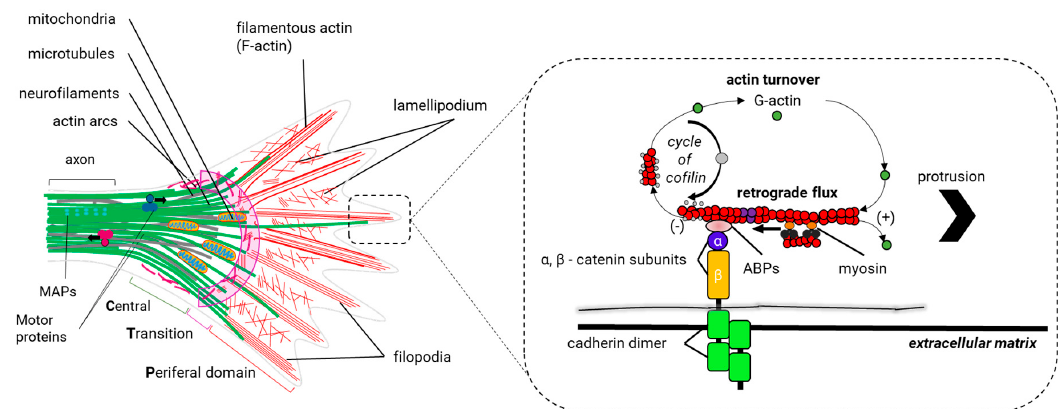
Figure 10. Molecular structure of the cytoskeleton in the growth cone. The growth cone can vary its shape and size very fast, but usually, three domains are distinguished: the central (C) and peripheral (P) domains, and an intermediate zone called the transition zone (T) (left). The growth cone is an expanded and motile structure where several regions can be distinguished. In the axonal axis, microtubules (MTs) (green lines) are organized in parallel bundles by the microtubule-binding proteins (MAPs), such as tau (cyan spheres), whereas in the C domain, MTs are dispersed and are extended individually through the T zone until they reach the P domain. Here, MTs are aligned with the bundles of actin filaments (F-actin, red lines) in the filopodium. Here, actin filaments are organized in parallel beams that are extended back through the P domain to end up in the T zone, where they are cut in short filaments by a still unknown mechanism. F-actin in the lamellipodium is organized in branched networks. Actin arcs (fuchsia lines), composed by anti-parallel beams of F-actin and the motor protein myosin II (not shown in the graph) are located in the T zone and at the periphery of the C domain. Actin arcs produce the compressive forces in the C domain that bend the scattered MTs and facilitate their grouping in the wrist of the growth cone. Motor proteins supply the growth cone with the materials and organelles necessary for the formation of the new axonal segment (anterograde transport) and they transport vesicles involved in the endocytic pathways (retrograde transport). In the filopodia (right), the balance between polymerization and the retrograde flow of F-actin controls the protrusion of the growth cone. F-actin is disassembled in the T zone and is polymerized in the filopodia of the growth cone. The protrusion phase occurs when the polymerization rate of F-actin exceeds that of the retrograde flow. Once the filopodium recognizes an adhesive substrate in the extracellular matrix, it binds to it using adhesion proteins such as cadherins, which in turn interact with heterodimeric transmembrane receptors of α / β —integrin in the growth cone. These receptors interact with some actin-binding proteins (e.g., vinculin, talin, paxillin) to communicate F-actin with the extracellular matrix. Src protein kinase and the focal adhesion kinase (FAK) bind to actin-binding proteins (ABPs) to activate the adhesion of other additional proteins (not shown in this figure). It is believed that the union of the ABPs restricts the retrograde flow and strengthens the polymerization of actin to generate the protrusion of the membrane.